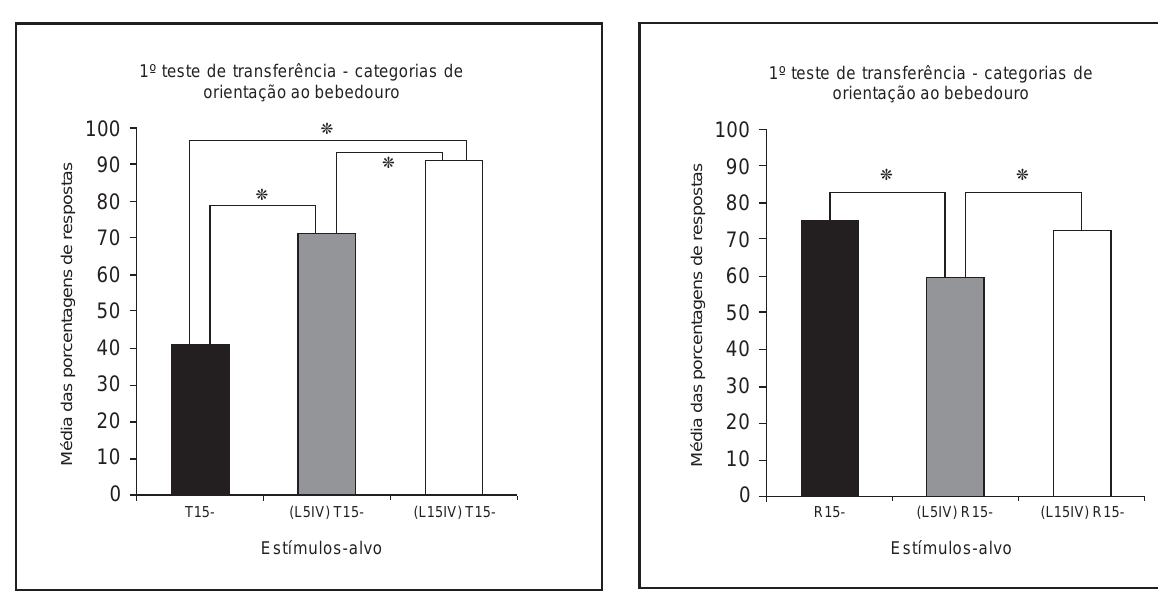
Figura 4. Médias das porcentagens de resposta das categorias de orientação ao bebedouro agrupadas ( head-jerk +lamber e\ou farejar o bebedouro) no 1o teste de transferência, durante a apresentação do estímulo alvo das seguintes práticas: R15-, L15 IV R15- e L5 IV R15-. L= luz; R= ruído; IV= intervalo vazio. (Durante a fase de aquisição as práticas foram: L15 IV T5+; T5- ; L5 IV R15- ; R15+). Diferença estatística